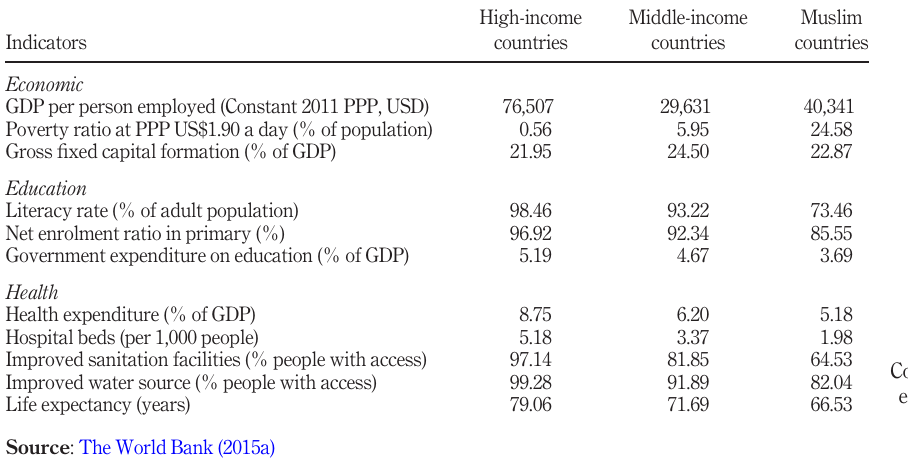
Table I. Comparison of